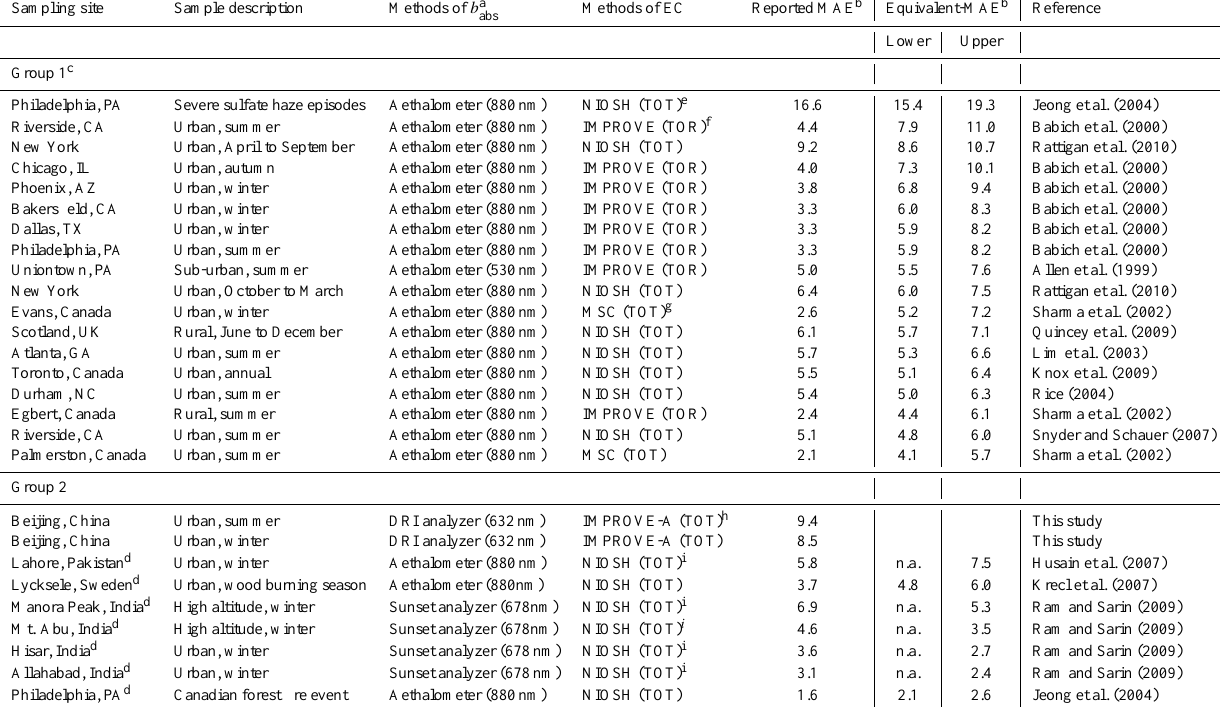
Table 1. Previously published mass absorption efficiency (MAE, in m 2 g − 1 ) of elemental carbon (EC). The lower and upper estimates of the equivalent-MAE, which is the estimated value if using the same measurement methods as used in this study, are also shown. See Supplement for the detailed converting